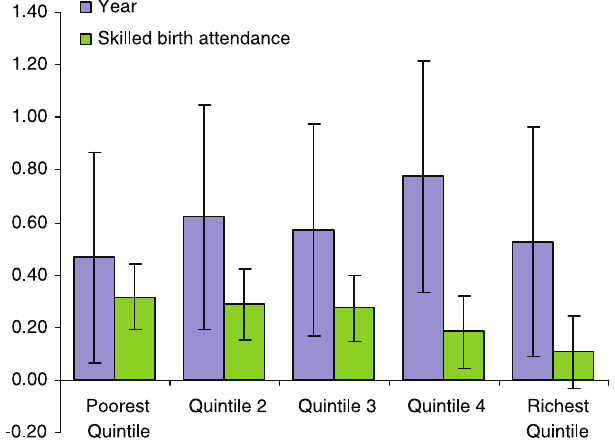
Figure 3. Multivariate Regression Coefficients and 95% Confidence Intervals for All Income Quintiles for Skilled Birth Attendance and Year of